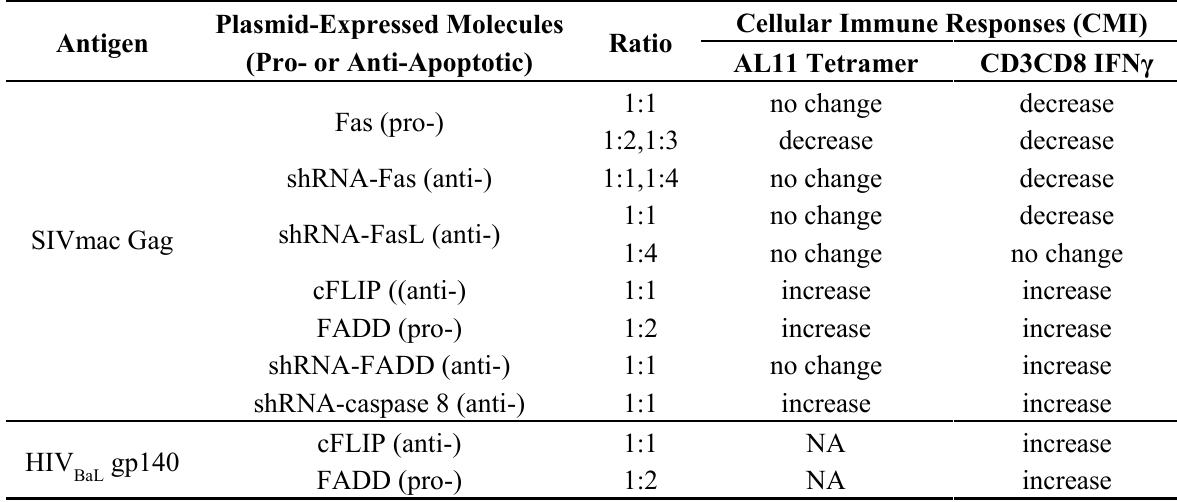
Table 1. Modulation of cellular immune responses in mice after DNA vaccination by co-delivering Fas-pathway molecules 1 . Cellular Immune Responses (CMI) Plasmid-Expressed Molecules Antigen Ratio (Pro- or Anti-Apoptotic)